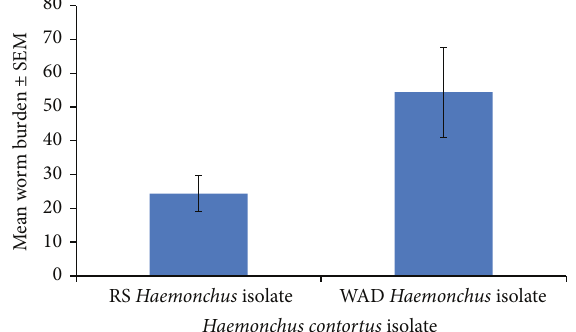
Figure 3: Mean body weights of Nigerian West African Dwarf (WAD) goats given a single pulse infection with either a Red Sokoto (RS) or a WAD goat isolate of H. contortus .